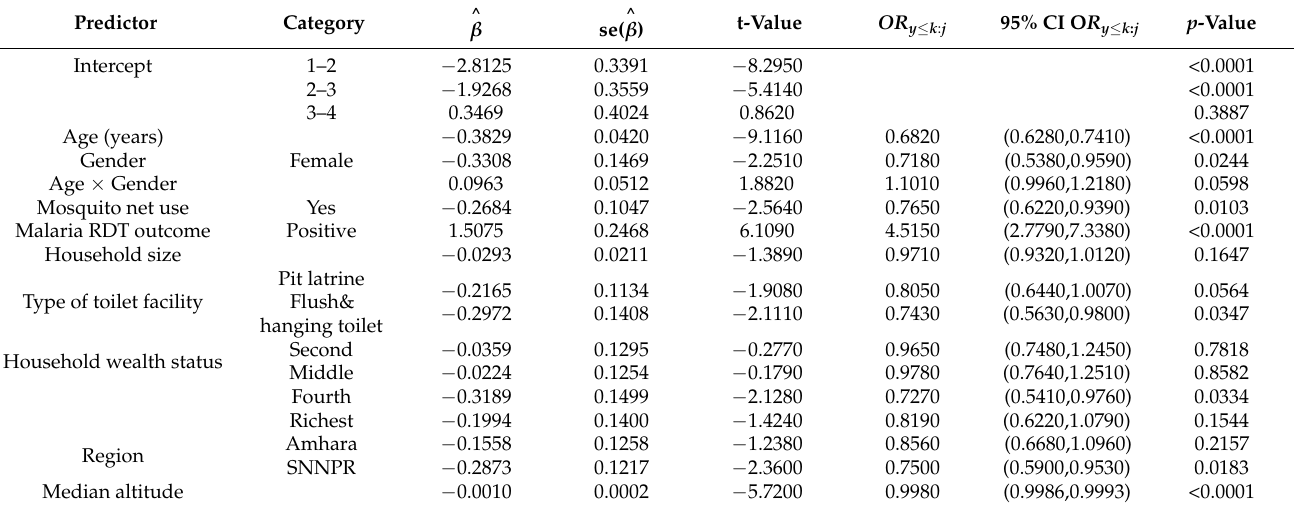
Table 4. Results for the final cumulative logit model for the relationship of anaemia prevalence to predictor variables considering survey